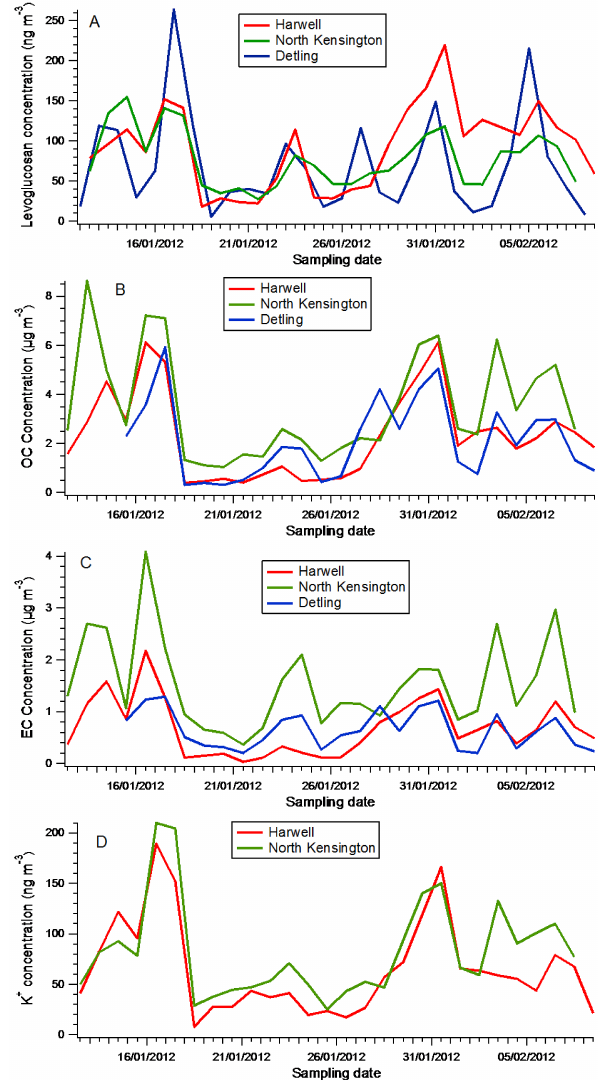
Figure 3. Time series of the concentration of (a) levoglucosan, (b) OC, (c) EC and (d) K + at Harwell, NK and Detling. No potassium data are available for Detling.